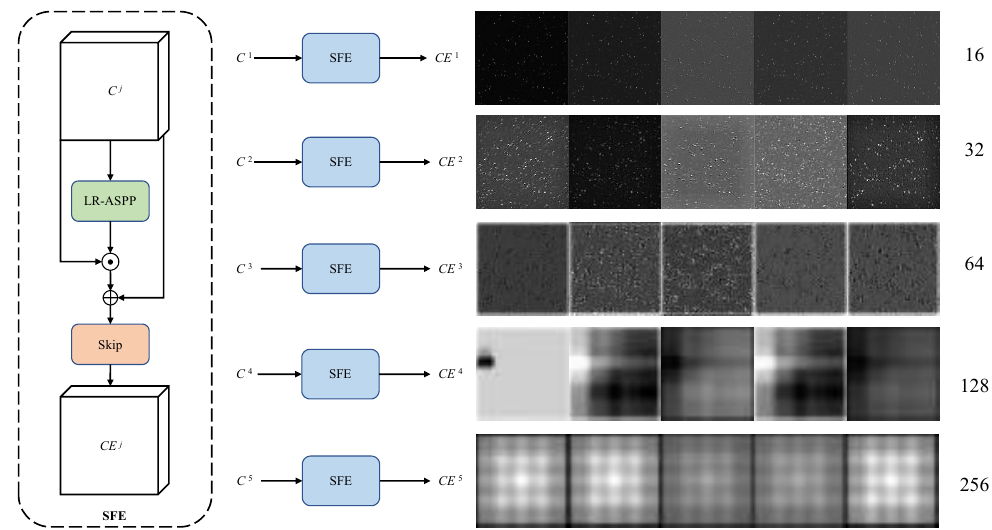
Figure 4. Spatial feature enhancement